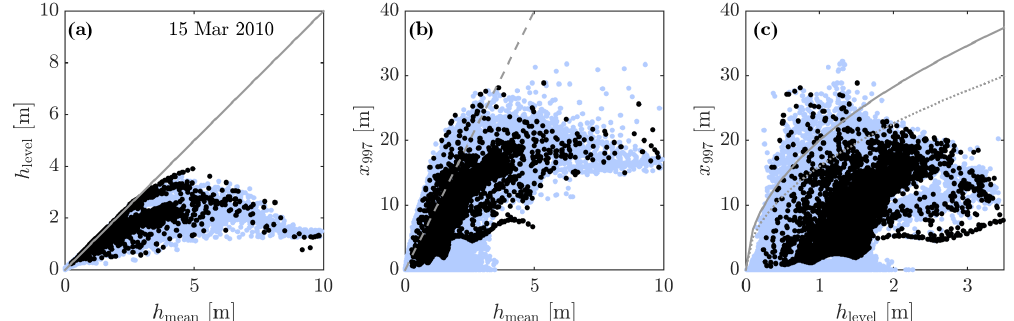
Figure 2. (a) Relationships between level ice thickness h level , defined as the mean thickness of ice thinner than 4m, and mean ice thickness h mean . The full line indicates a 1 : 1 ratio. (b) The largest keel thickness x 997 as a function of the mean ice thickness h mean . The grey dashed line represents the LKD parameterization. (c) x 997 as a function of h level , with the solid and dashed lines showing the empirical relationship of Melling and Riedel (1996) and Amundrud et al. (2004), respectively. Blue dots represent all grid points for 15 March 2010 while black dots show a subset with A > 0 .